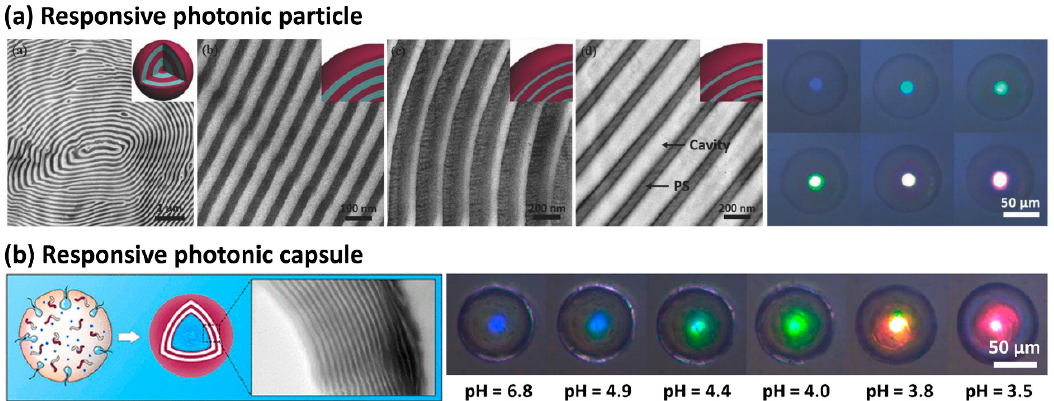
Figure 7. ( a ) Solvent-responsive photonic particles of PS- b -P2VP comprising concentric lamellae (reprinted with permission from [89], Copyright 2018, Wiley-VCH). ( b ) pH-responsive photonic crystal microcapsules of PS- b -P2VP with parallel lamellar layers (reprinted with permission from [90], Copyright 2020, American Chemical Society).